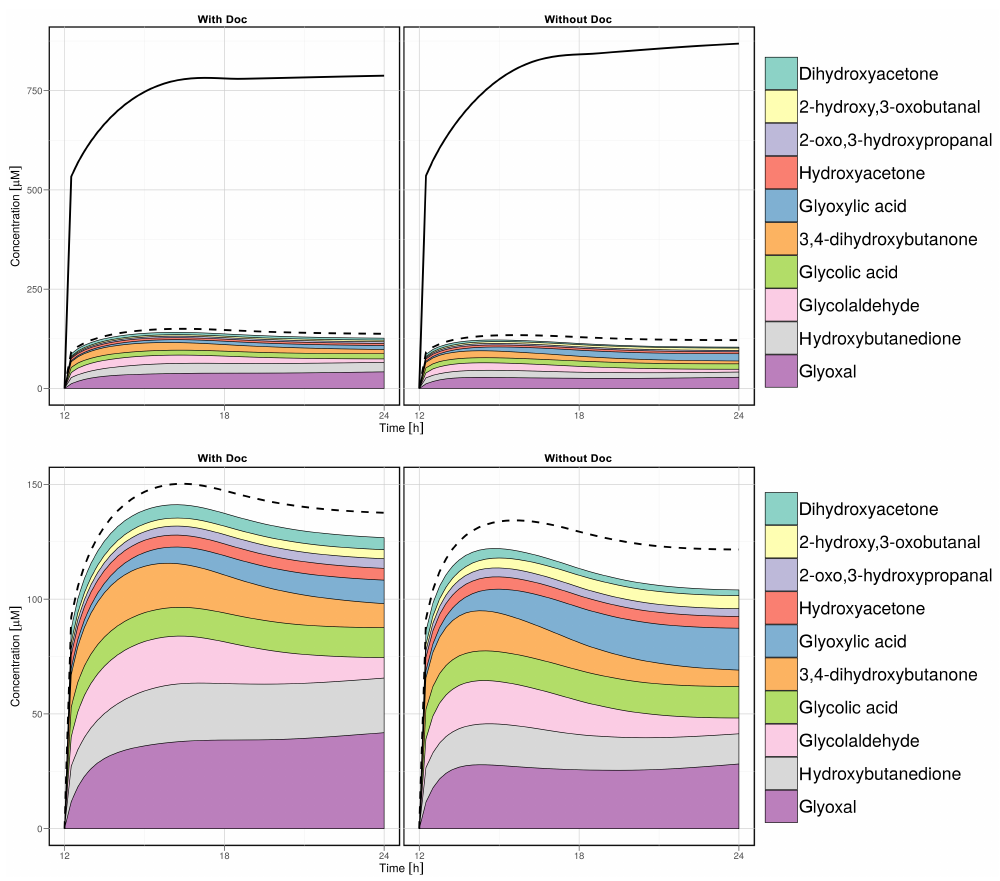
Figure 5. Contribution of the 10 most important species (in terms of concentrations) in the aqueous phase (colors). The solid line depicts the total concentration of dissolved organic compounds. The dashed line depicts the total concentration of reactive dissolved